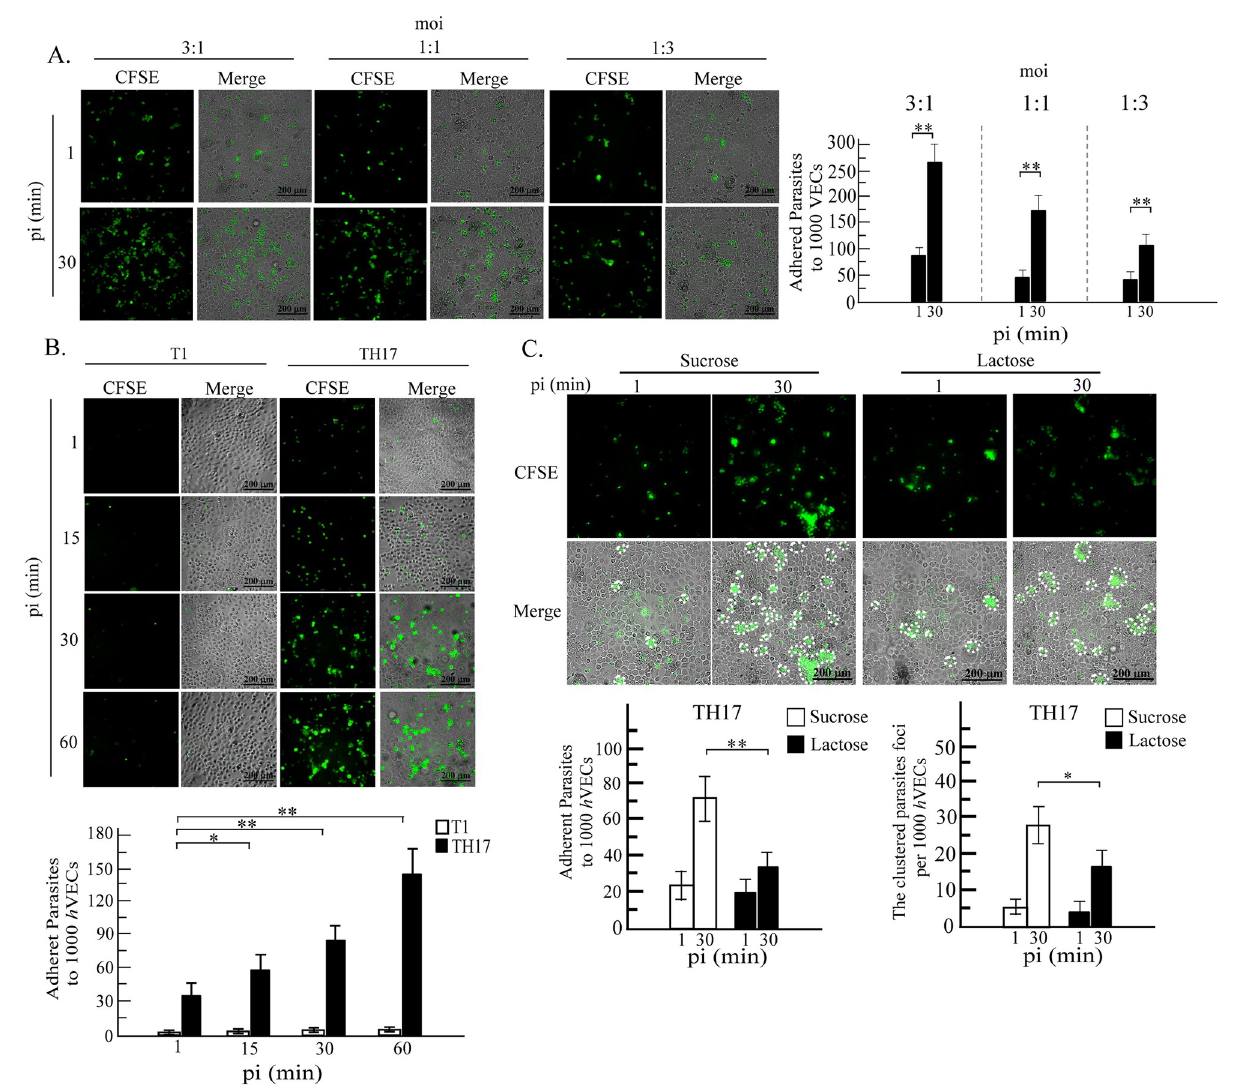
Fig 2. The kinetics of T . vaginalis trophozoites binding to h VECs. The trophozoites were labeled with CFSE and co-cultured with h VECs. A. trophozoites at a moi of 3 to 1, 1 to 1 or 1 to 3 were incubated with h VECs for 30 min. B. T1 or TH17 trophozoite were co-incubated with h VECs (moi 1:3) for 1, 15, 30 or 60 min. C. trophozoites were co-incubated with h VECs (moi 1:3) in the presence of 250 mM sucrose or lactose for 30 min and after the removal of unbound trophozoites, cell cultures were fixed for imaging by fluorescence and phase-contrast microscopy. PI, post-infection. The clustered foci with over three trophozoites are circled by white-dashed lines. The experiments were performed in triplicate and the average number of binding trophozoite or clustered foci per 1,000 h VECs were measured as shown in the bar graphs (mean ± SD). The statistical difference was analyzed by the Student’s t-test with P < 0.05 ( � ), P < 0.01( �� ), and ns, not